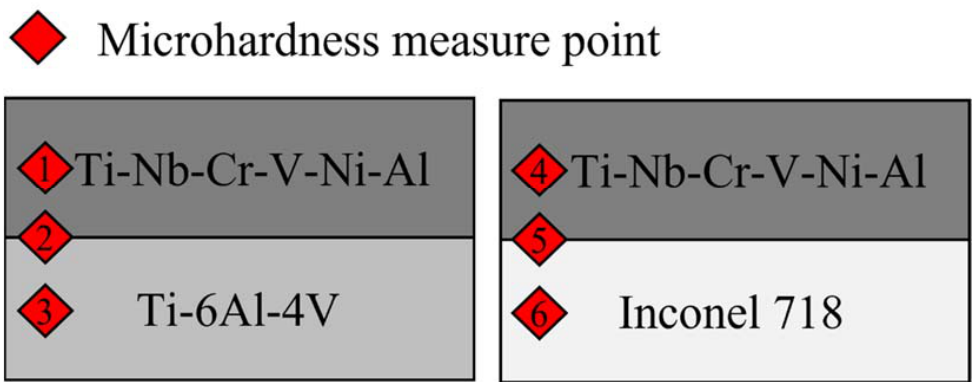
Figure 10. The measure point for the microhardness of Ti ‐ Nb ‐ Cr ‐ V ‐ Ni ‐ Al deposited on the substrates.